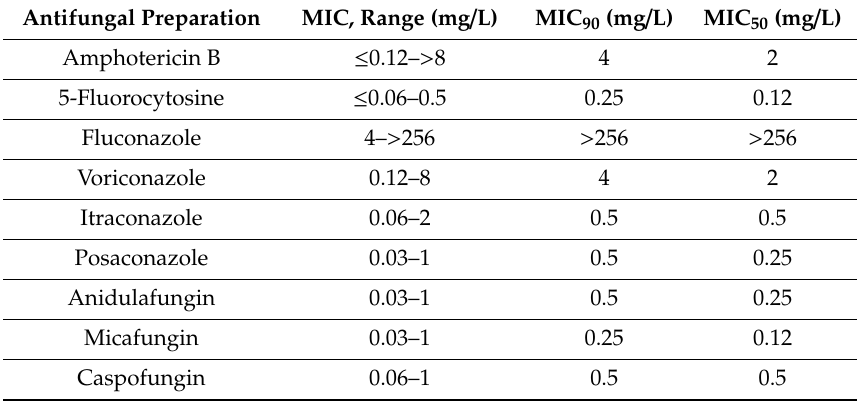
Table 1. Minimum inhibitory concentrations results for C. auris